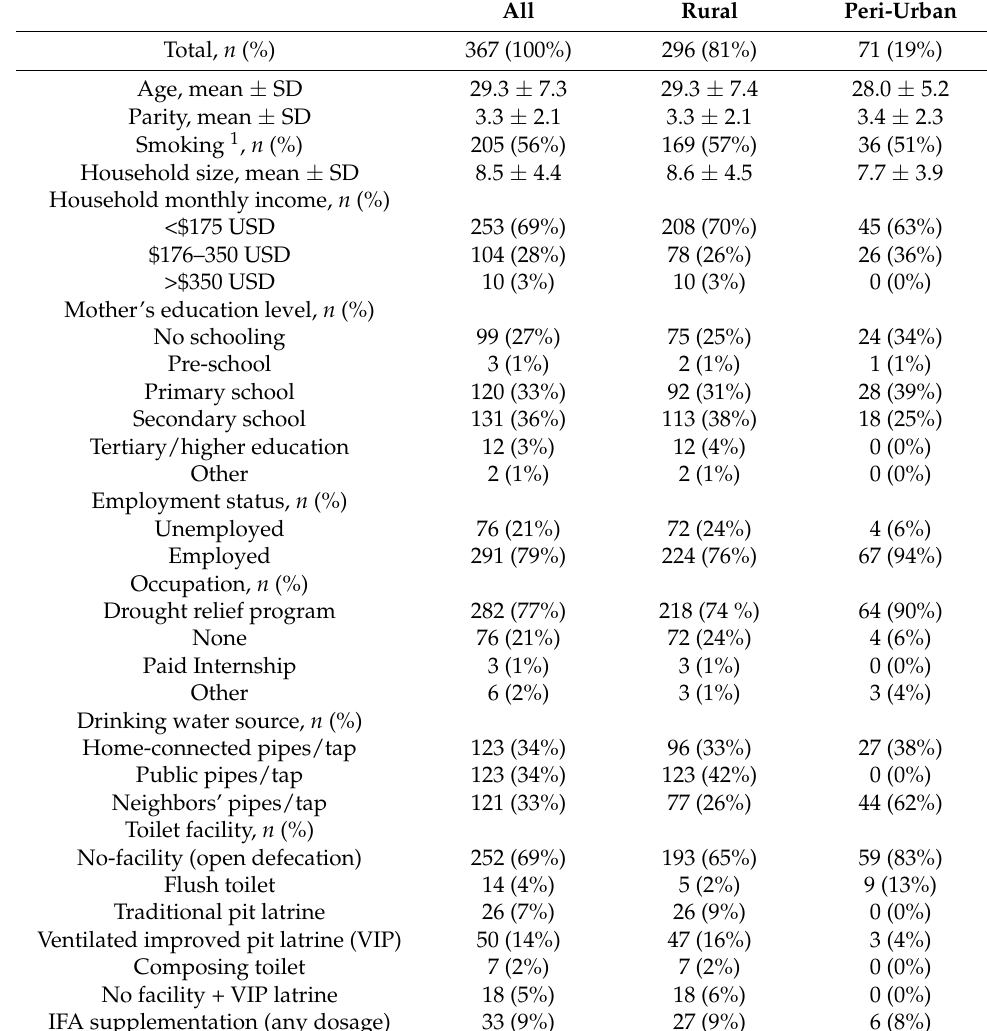
Table 1. Descriptive characteristics of enrolled San women in rural